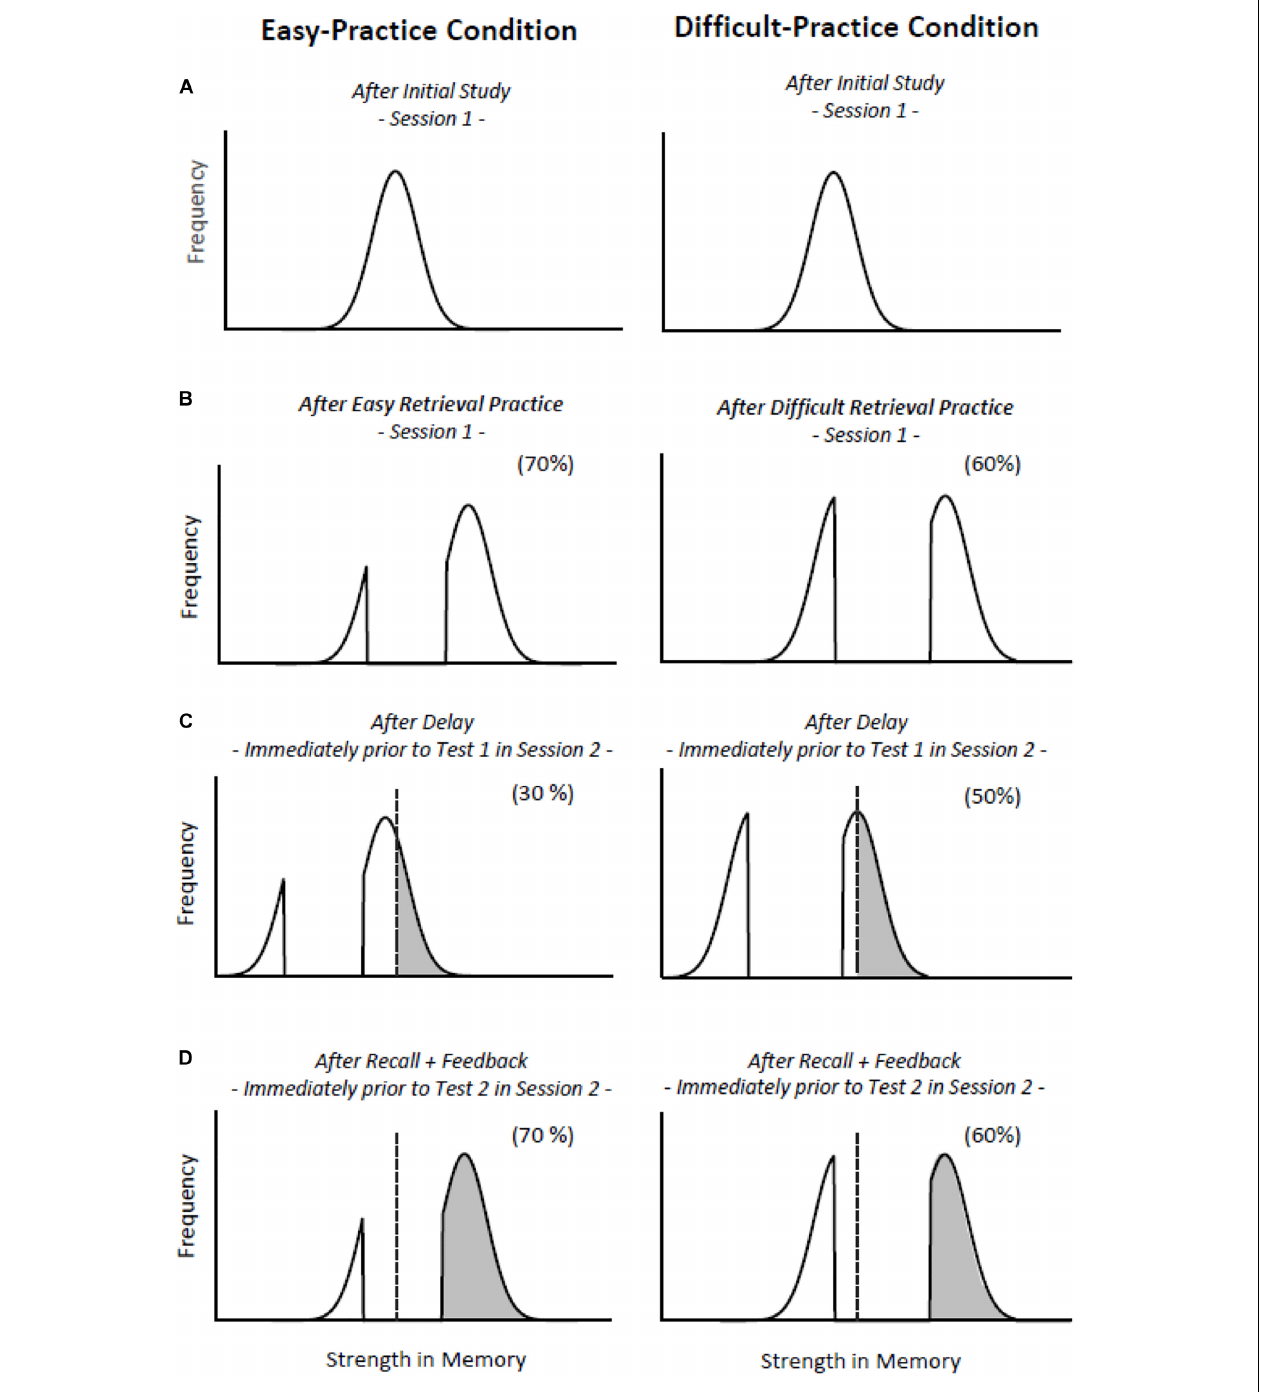
FIGURE 2 | An application of the bifurcation model to the retrieval-effort effect. The left and right columns show the hypothetical strength distributions of items after easy and difficult retrieval practice. (A) After initial study, two identical strength distributions arise in the two retrieval practice conditions. (B) Successfully retrieved items get a boost in strength, whereas items not successfully retrieved do not gain any strength. This boost is more pronounced in the difficult-practice than the easy-practice condition. (C) All items lose strength with delay, but, due to the higher strength levels of the successfully retrieved items after difficult than easy retrieval practice, the decline in recall may be less dramatic in the difficult-practice than easy-practice condition, i.e., the retrieval-effort effect may arise in Test 1. (D) All items gain strength after recall and feedback, but because a higher ratio of items may be below the recall threshold in the easy-practice than difficult-practice condition, the increase in recall performance may be more pronounced in the easy-practice than the difficult-practice condition. Thus, in Test 2, the retrieval-effort effect may be reduced, or even